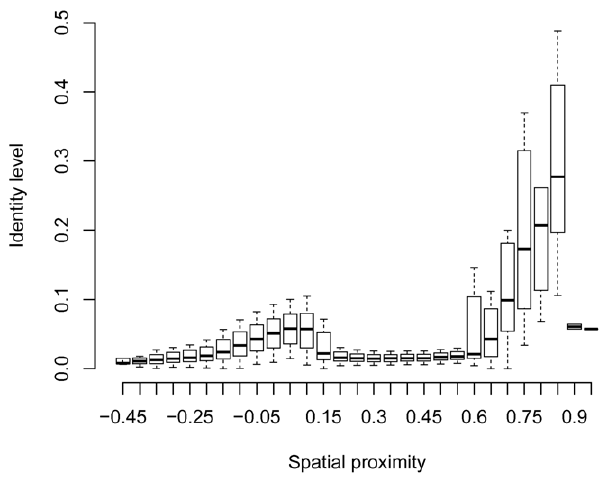
Figure 1. Sequence identity levels in 29 considered intervals of spatial proximity values between 1-Mb fragments of different chromosomes in the genome-wide correlation matrix C [ 4 ] (see Methods for the details). Negative spatial proximity values correspond to fragments distant from each other, positive values correspond to proximal fragments. The whisker boxes show quartiles, median (the line in the box), min and max values (the lines outside the box).